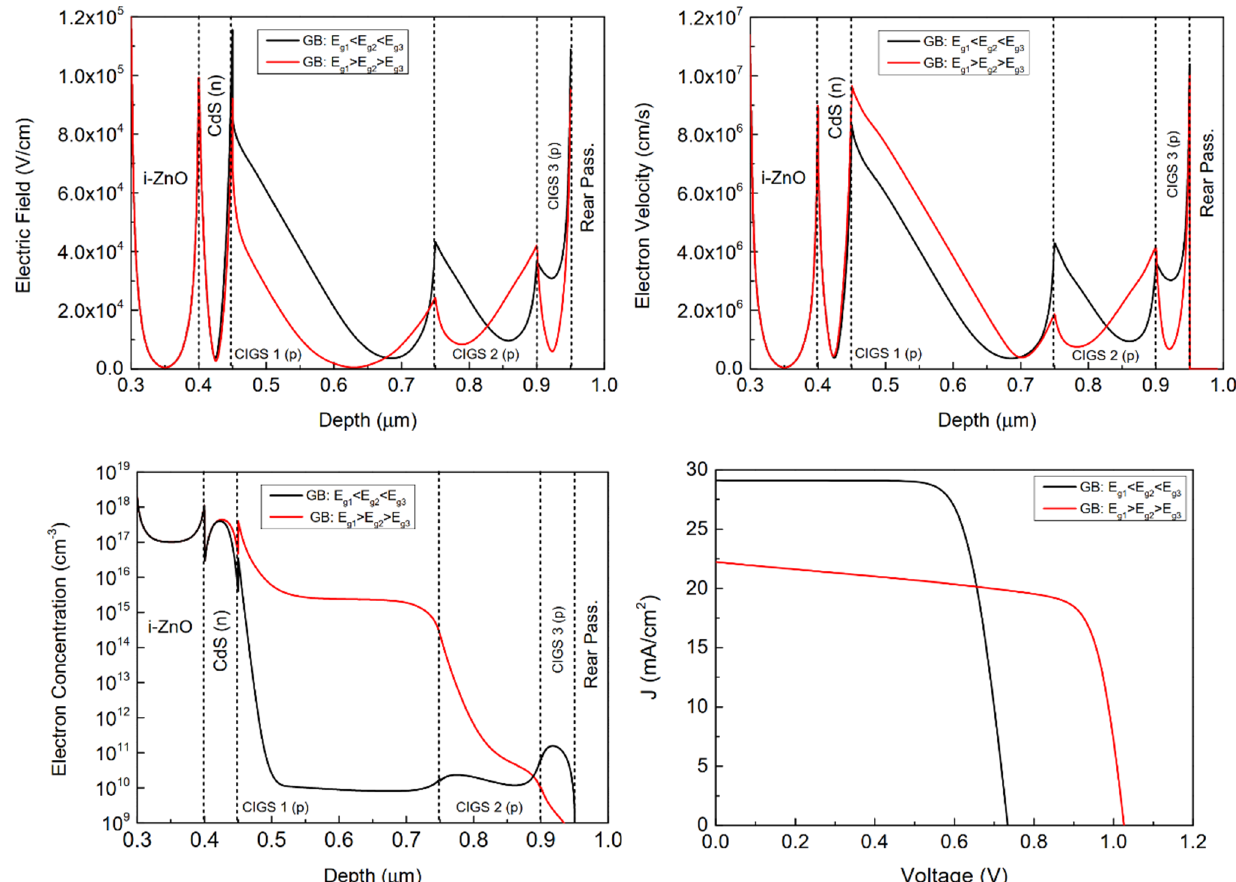
Figure 18. Electric field distribution, electron velocity, and electron concentration inside the u-CIGS structure. J–V characteristics with two different absorber configurations.